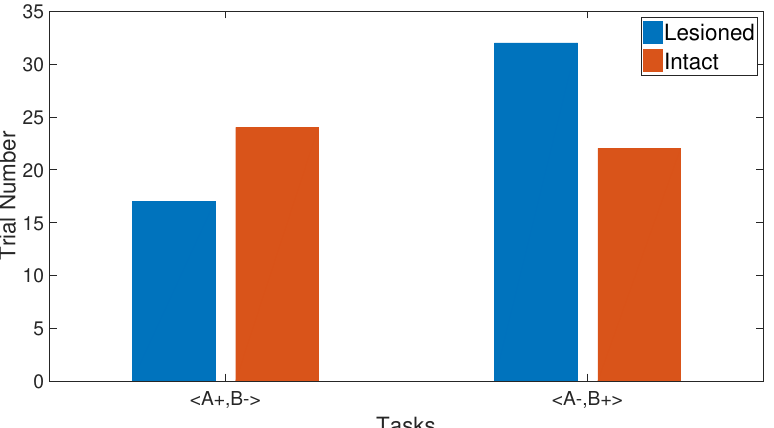
Figure 10. Discrimination reversal for both intact and lesioned systems of CHCQ